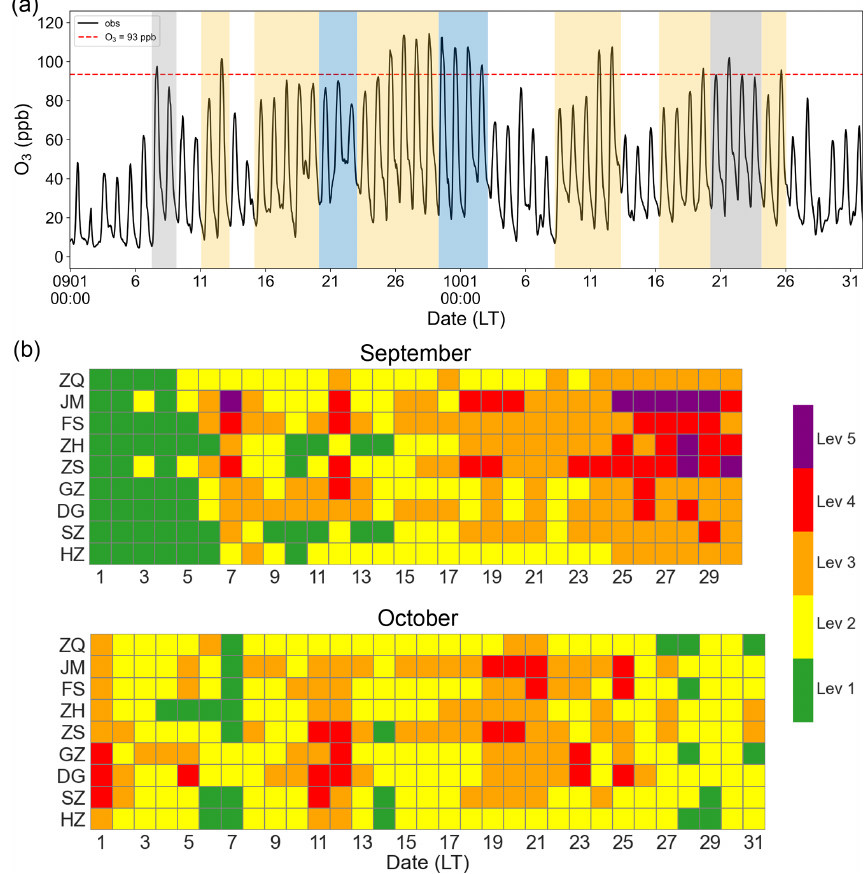
Figure 2. (a) Diurnal variation in O 3 concentrations in nine cities (a total of 56 stations averaged) in the PRD from 1 September to 31 October 2019. The red dotted line indicates the O 3 concentration of 93ppb. Yellow shading indicates the period affected by the subtropical high, blue shading indicates the period affected by the typhoon, and gray shading indicates the period affected by the synoptic patterns other than subtropical high and typhoon. (b) Calendar chart of O 3 concentration levels for September and October 2019. These cities are sorted by longitude. Levels (Lev) 1–5 in colored bars represent excellent, good, light pollution, moderate pollution, and severe pollution of air quality index categories in the Technical Regulation on Ambient Air Quality Index (AQI), respectively.